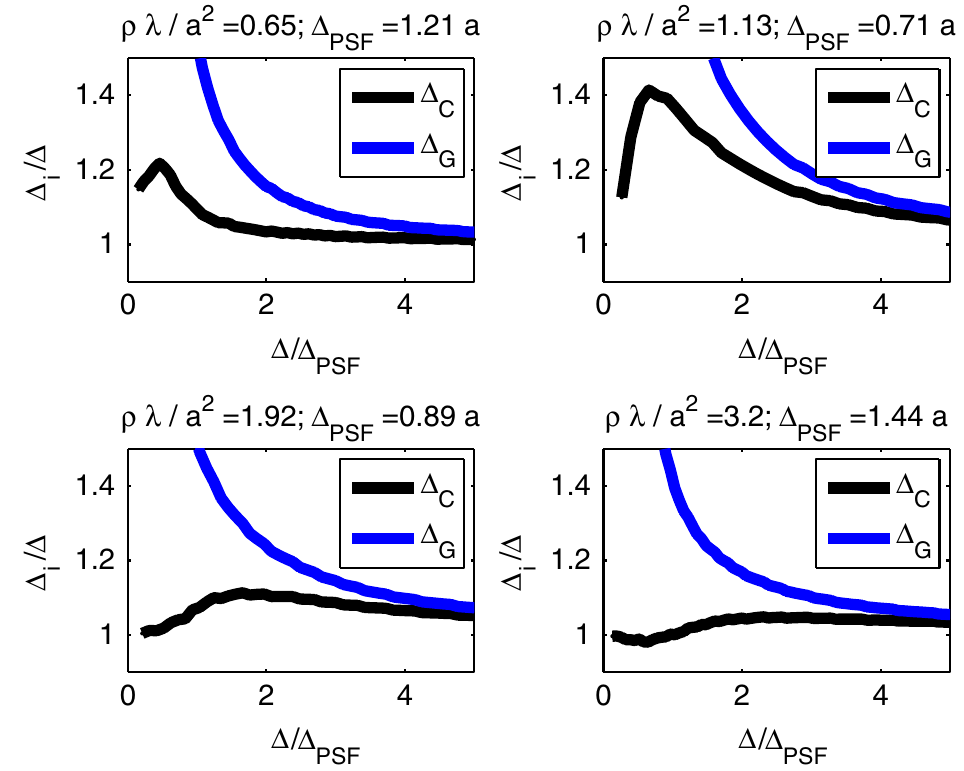
FIG. 8. (Color) Relative increase of the measured FWHM width introduced by convolution with the PSF and partial deconvolution with a Gaussian of the same FWHM